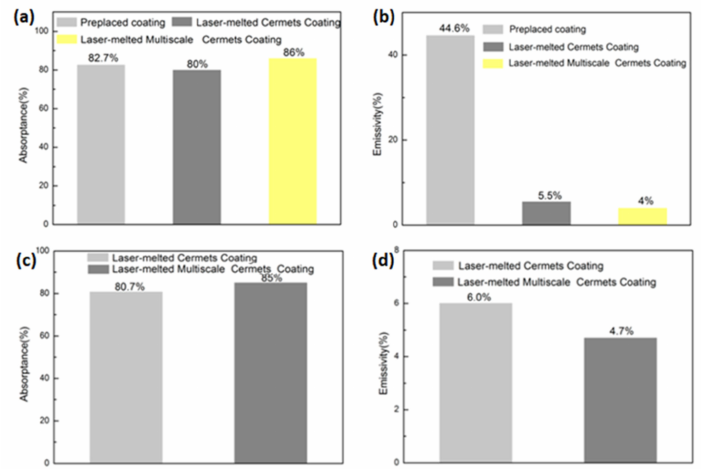
Figure 9. Absorptance and emittance of the laser-clad cermet coating: ( a , b ) as-produced conditions; ( c , d ) after heat treatment at 650 ◦ C for 200 h (graphs are re-elaborated from